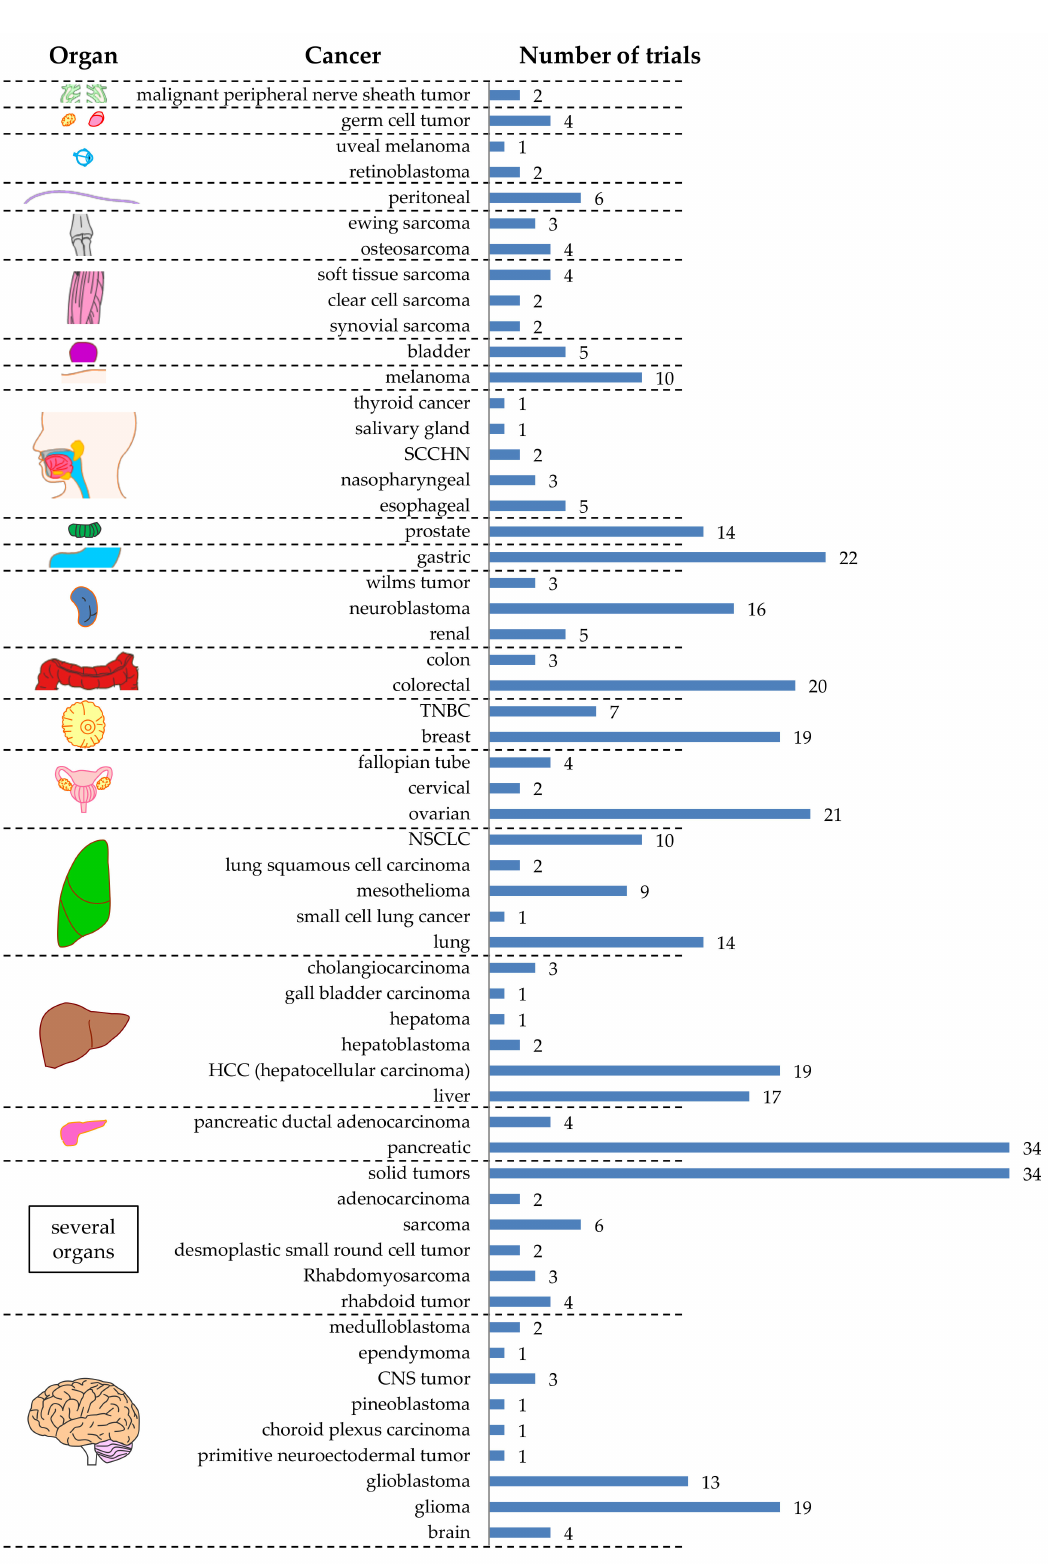
Figure 3. Schematic overview of the tumor entities targeted by CAR-T cells against solid tumors grouped by organ. The numbers indicate the number of clinical trials targeting this tumor. Data was extracted from clinicaltrials.gov. The Motifolio Scientific Illustration Toolkit was used for the generation of parts of this